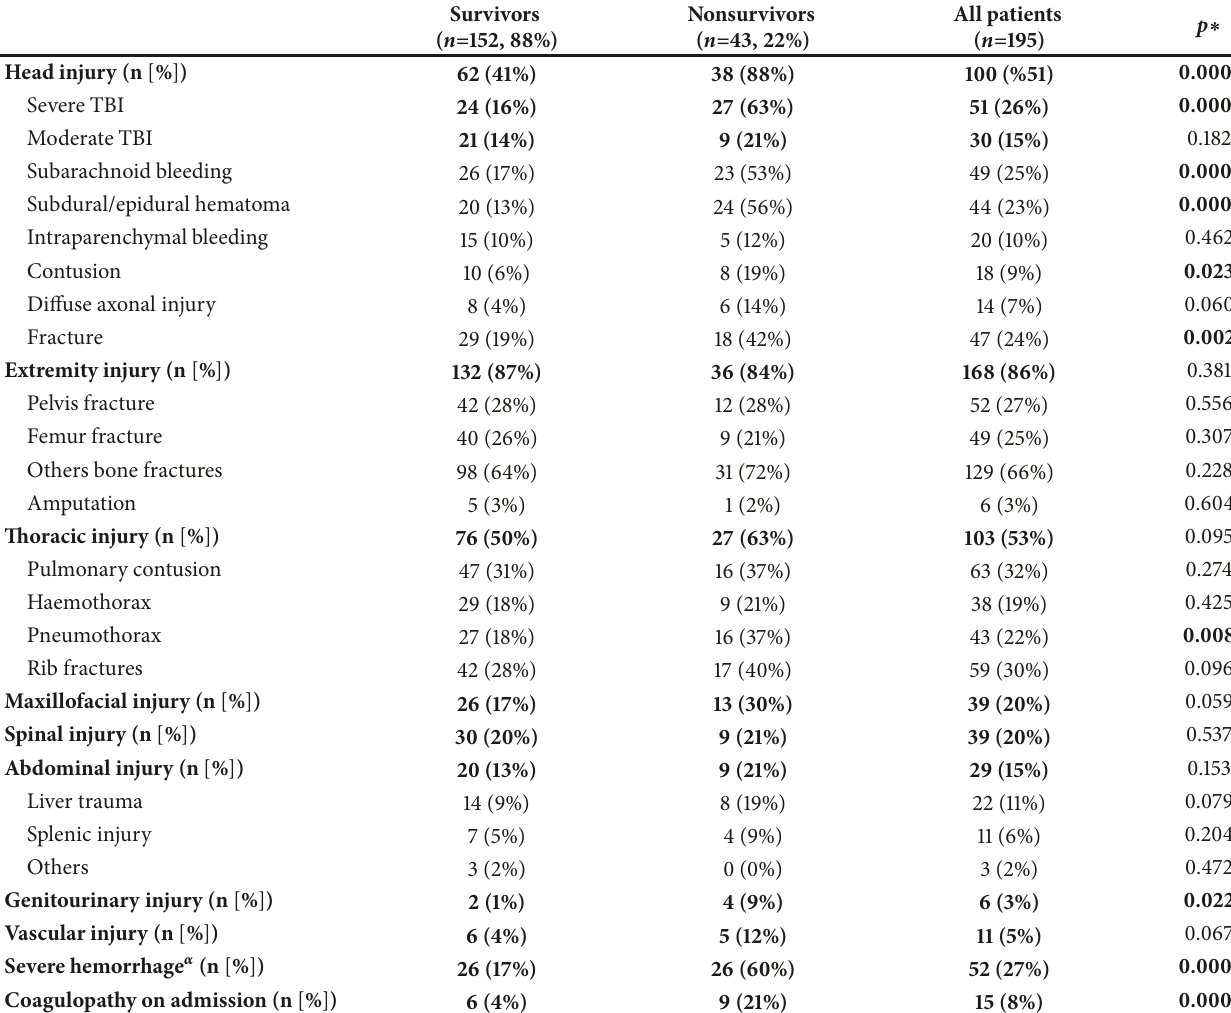
Table 4: Patterns of injury and diagnosis during ED evaluation according to physical examination, laboratory, and radiological findings for the 195